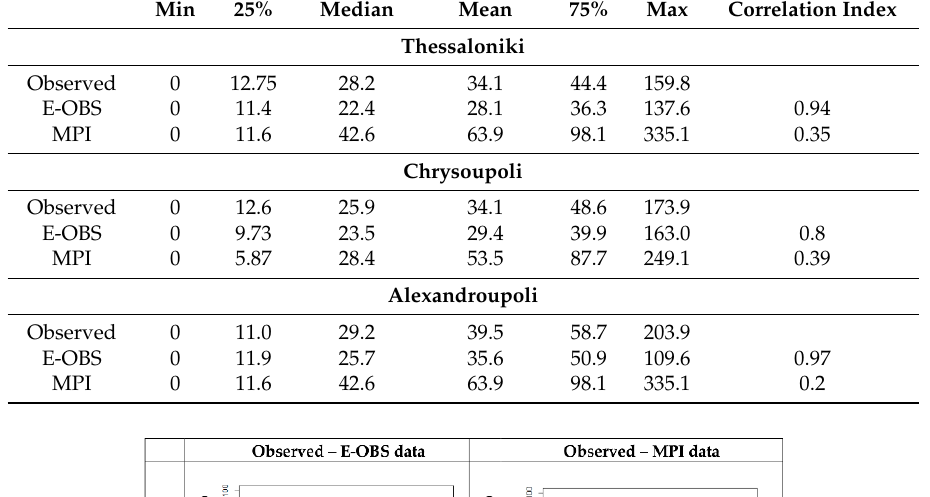
Table 2. Statistical results for observed, E-OBS and MPI datasets in mm. The correlation of E-OBS and MPI was calculated between these datasets and observed datasets.